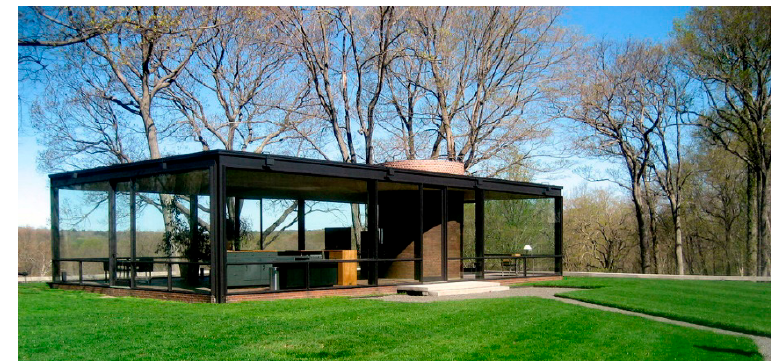
Figure 10. Glass House by Philip Johnson, New Canaan, 1949 [19].